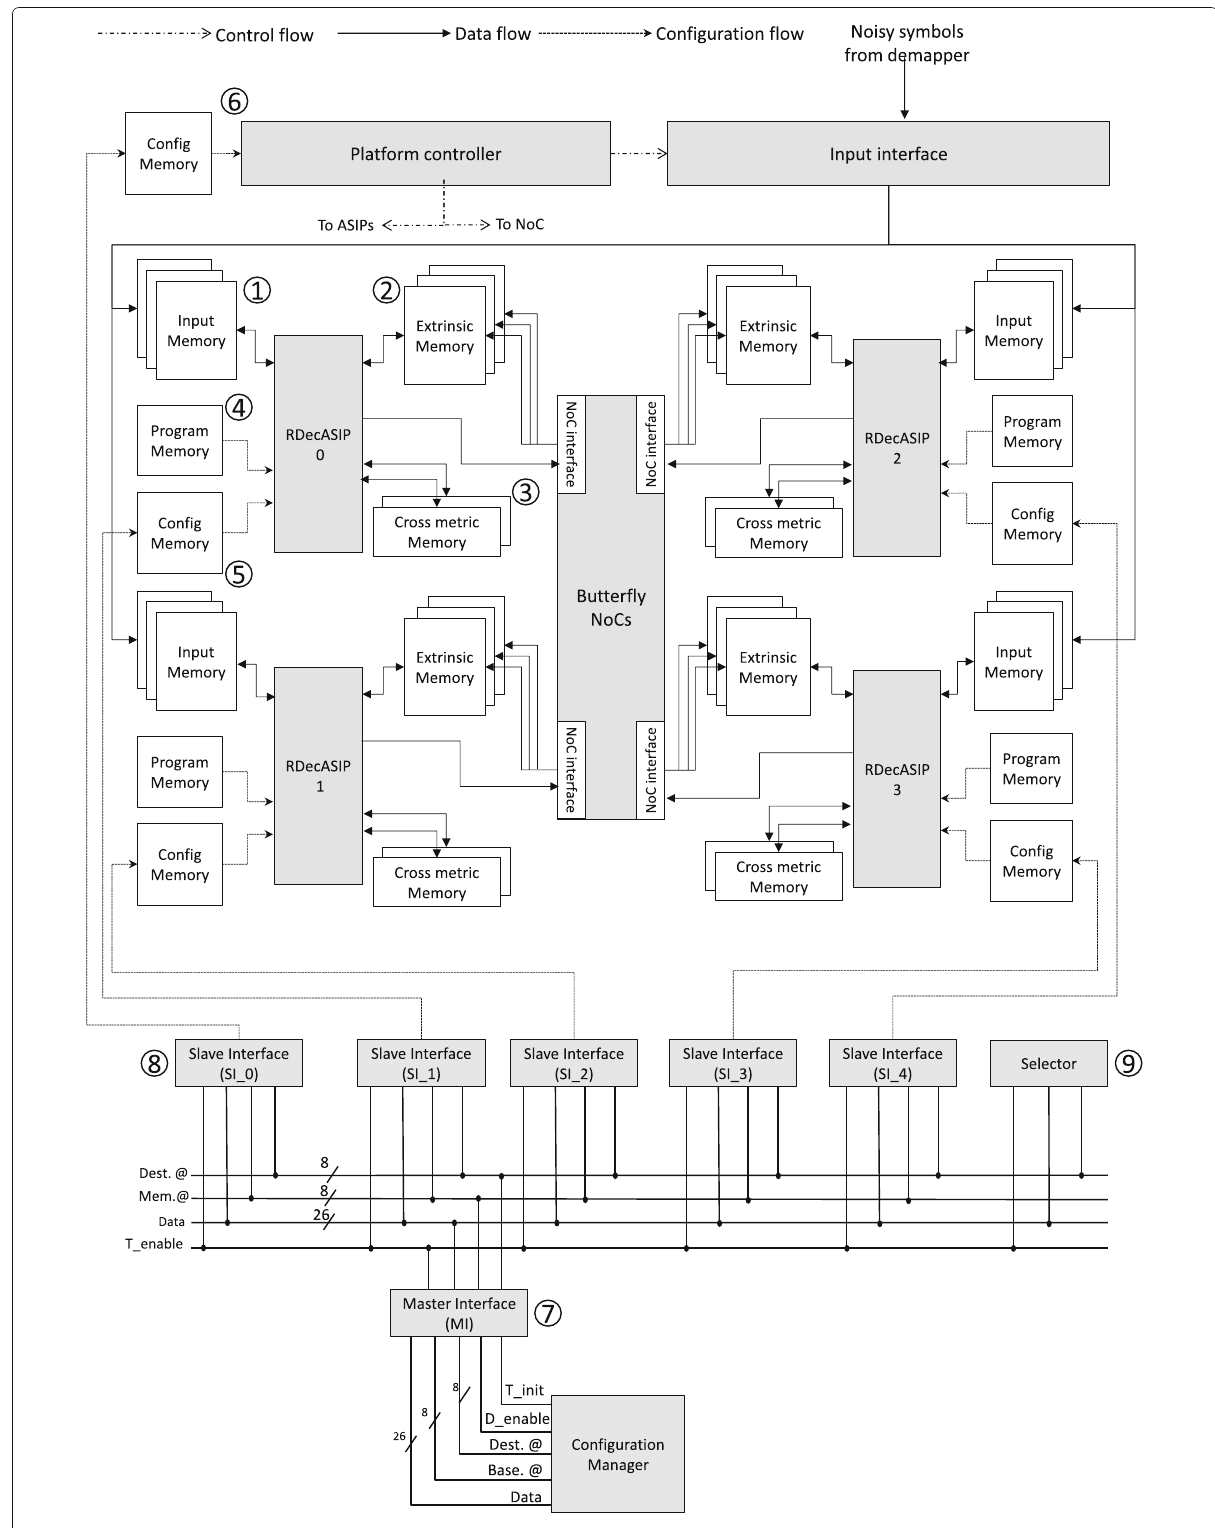
Fig. 4 Reconfigurable UDec system architecture example with 2 × 2